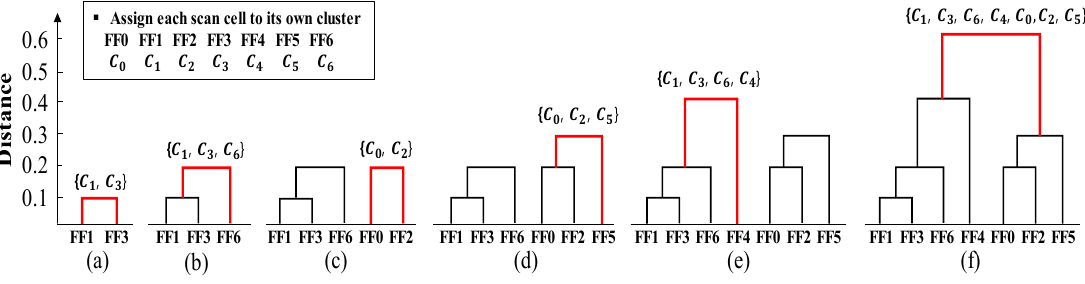
Figure 9. Scan correlation clustering process from ( a ) to ( f ) for dendrogram tree. The distance of cluster FF1–FF3 is the shortest at 0.1; hence, the FF1–FF3 cluster is merged into one cluster, as shown in Figure 9a. The distance matrix is then updated by recalculating the distance between the FF1–FF3 cluster and the other clusters. In the next step (Figure 9b), FF1–FF3–FF6 becomes one cluster because the distance of the FF1–FF3 and FF6 clusters is shortest at 0.15. This process is iteratively performed until the last all-inclusive cluster remains, resulting in the rightmost dendrogram tree, as shown in Figure 9f. The scan cell list (FF1, FF3, FF6, FF4, FF0, FF2, FF5), which corresponds to the leaves of the dendrogram tree, is then